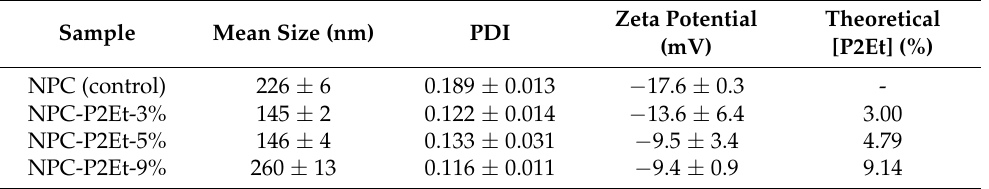
Table 2. Physico-chemical properties of the casein-based nanoparticles.